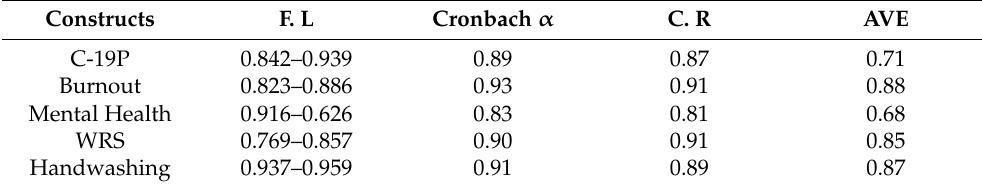
Table 3. Results of measurement analysis.